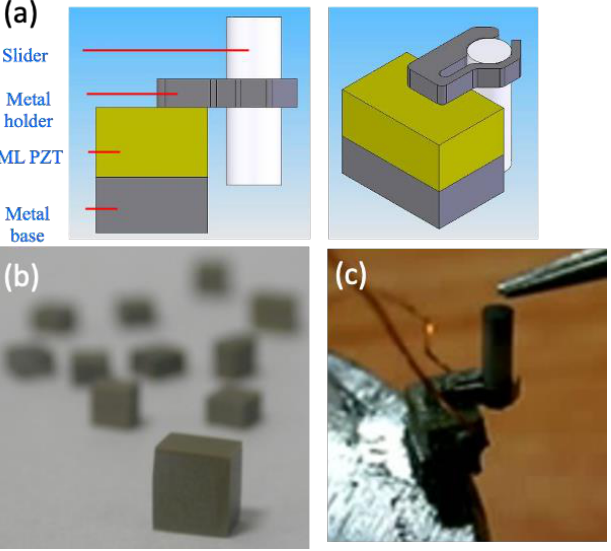
Figure 2. ( a ) Lobster USM design. ( b ) ML PZT for Lobster USM. ( c ) Lobster USM.